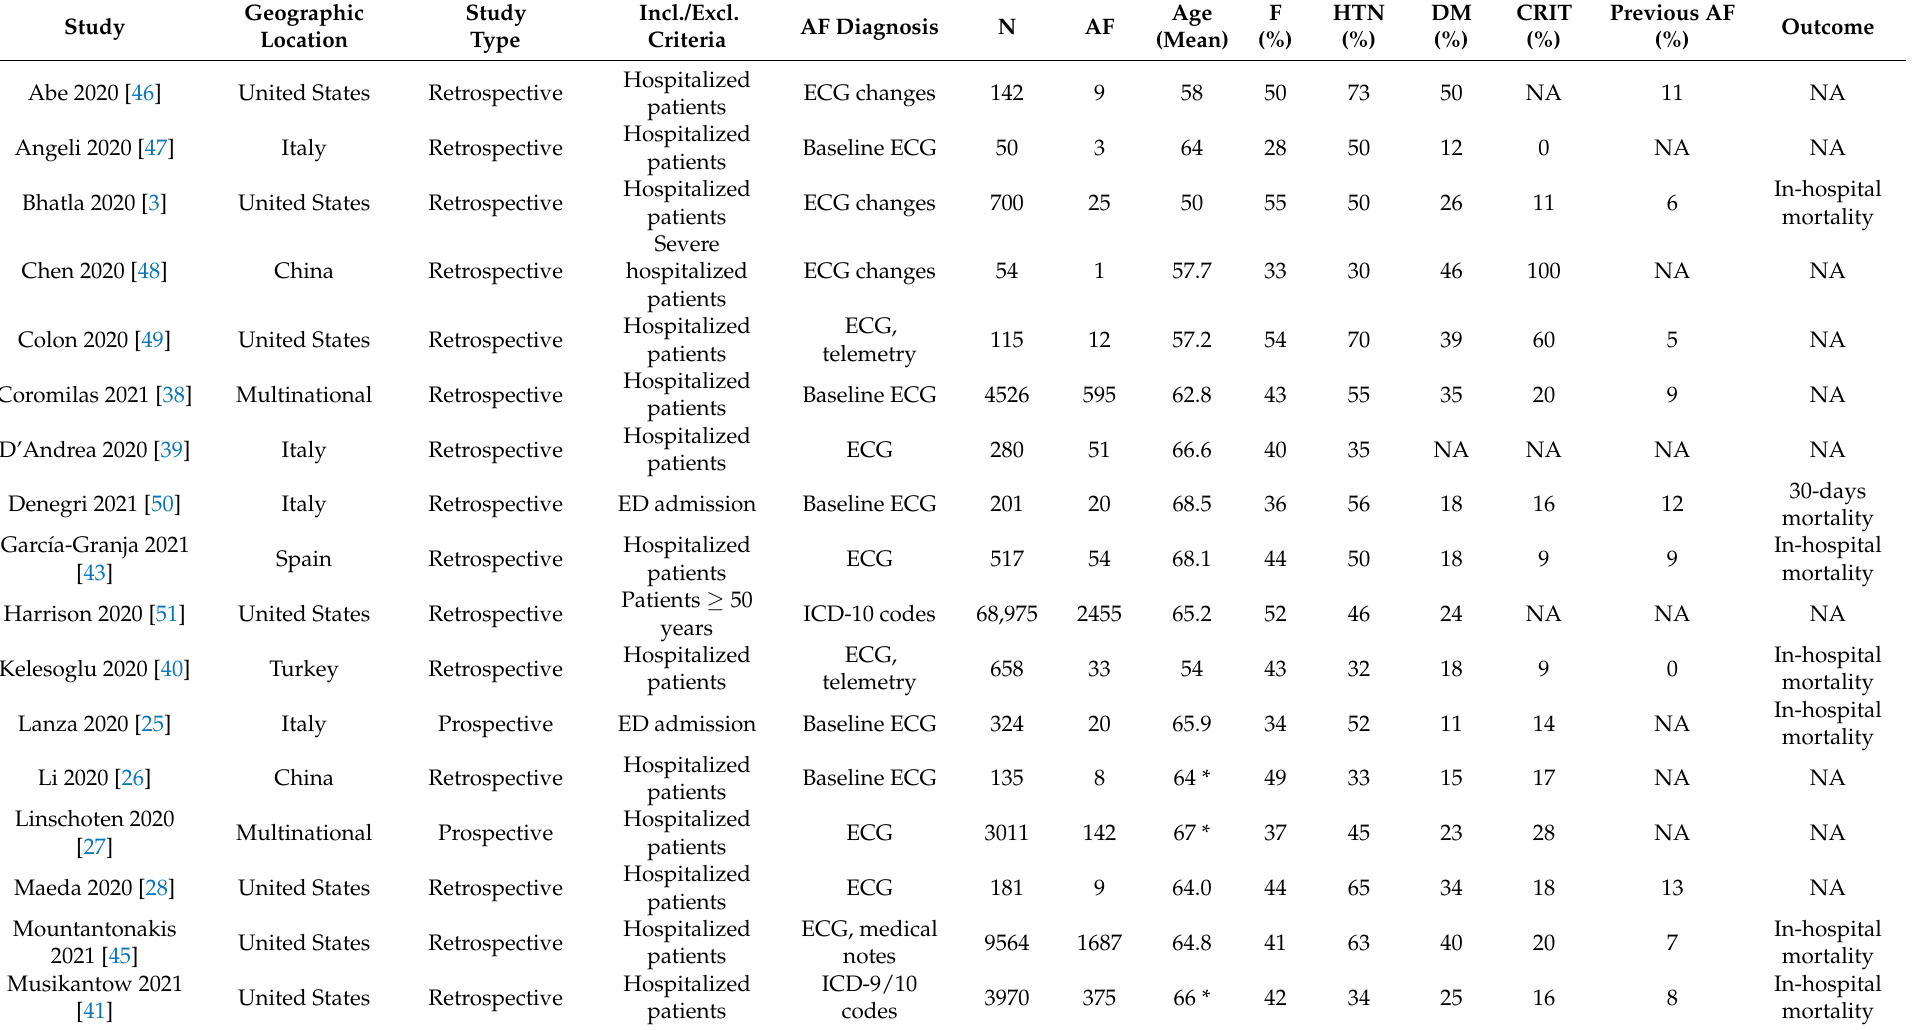
Table 1. Main characteristics of the studies included in the systematic